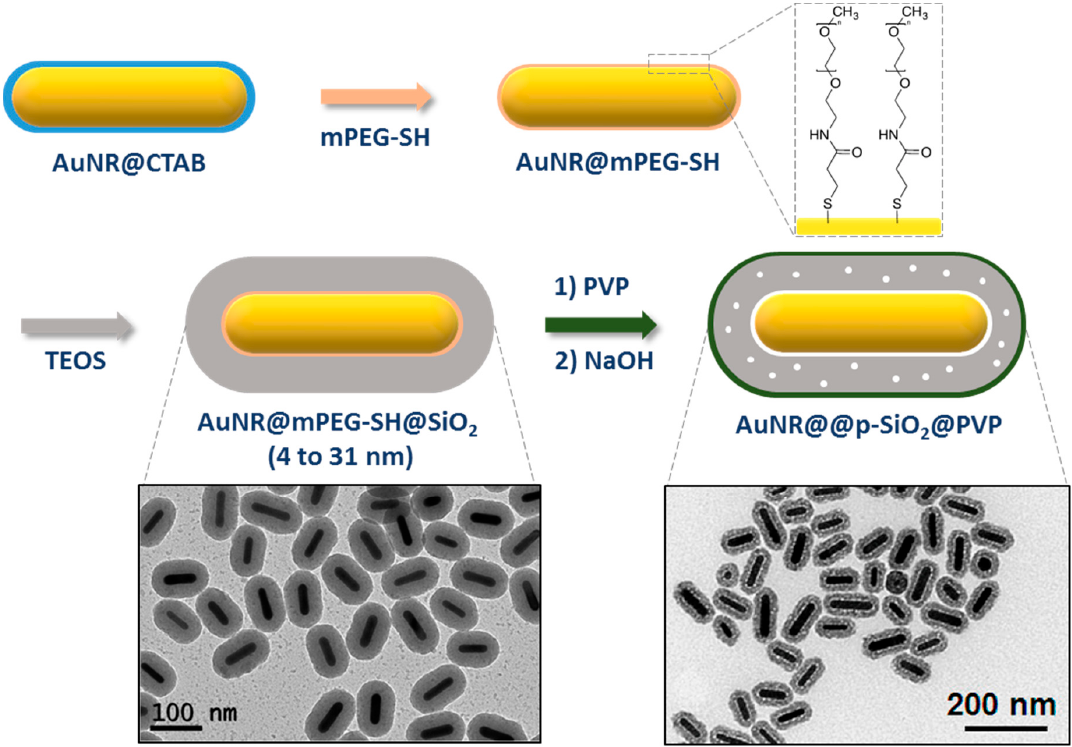
Figure 7. CTAB replacement by (O-[2-(3-mercaptopropionylamino)ethyl] O’-methylpolyethylene glycol (mPEG-SH) for silica growth and further induced porosity with the corresponding TEM images from ref [71] and [72].